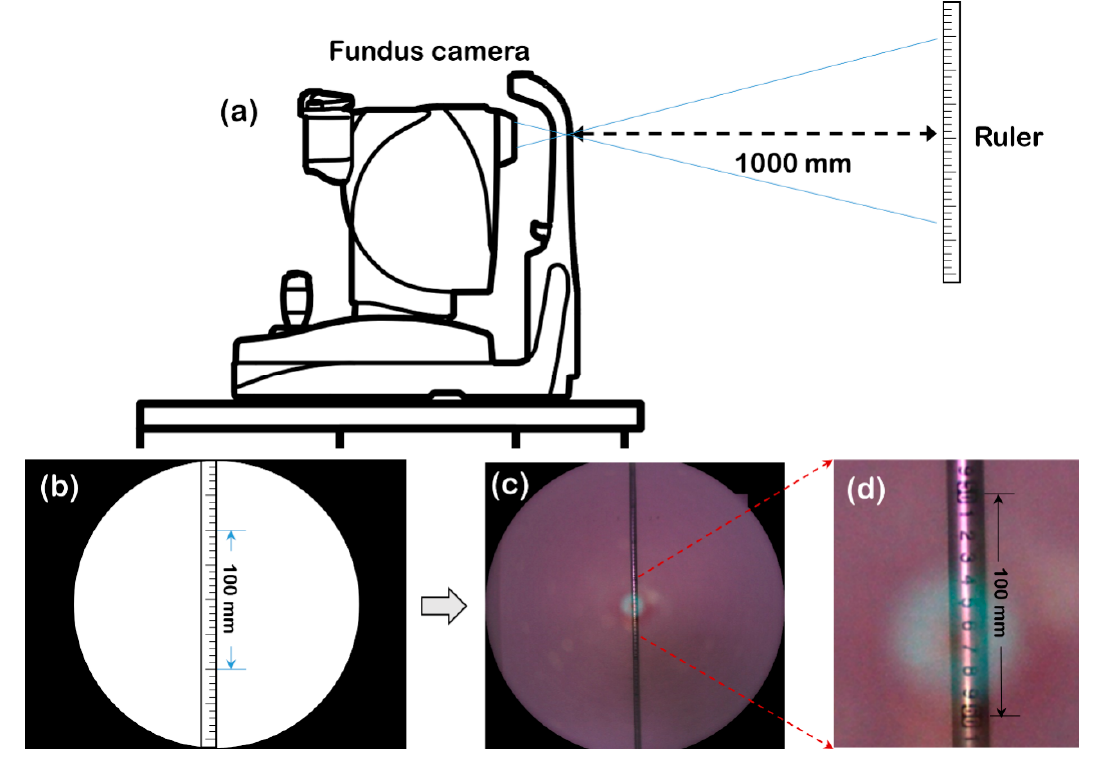
Figure 6. Diagram of pixel pitch measurement according to ISO 10940:2009. ( a , b ) are the schematic diagrams when shooting (place the ruler 1000 mm away from the pupil and ensure that the ruler scale in the center of the image can be seen clearly during shooting), ( c ) is the image acquired by actual measurement, and ( d ) is a partial enlarged view of ( c ).